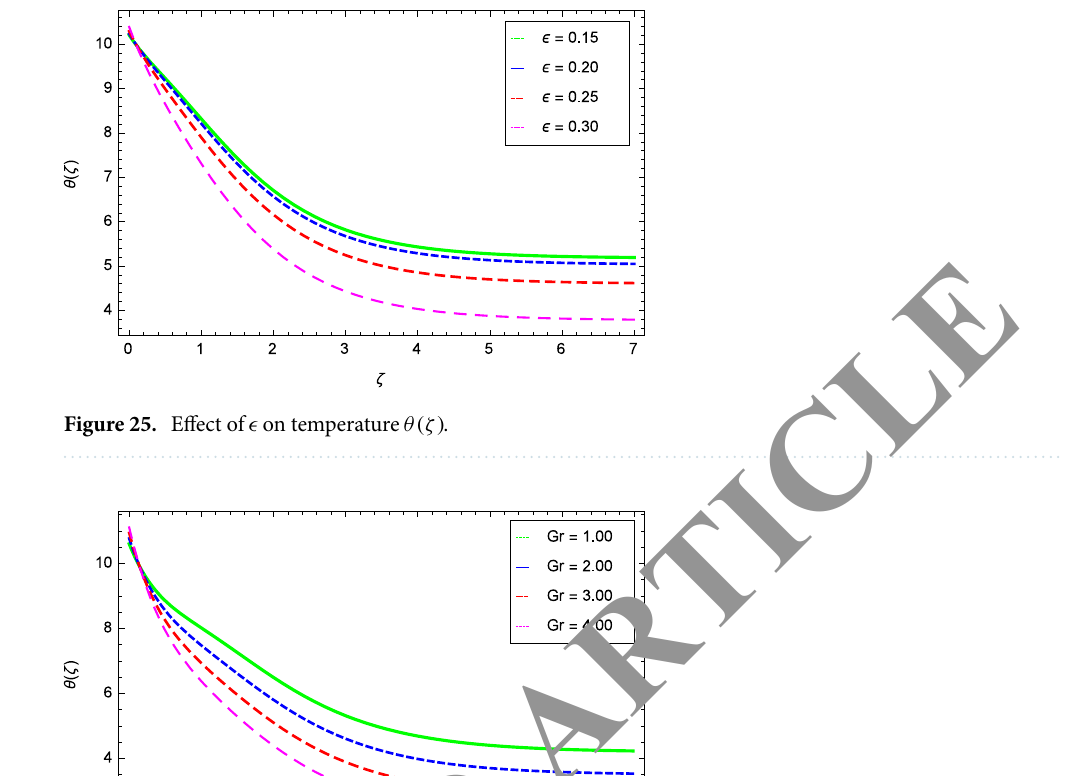
Figure 26. Effect of Gr on temperature θ(ζ) .